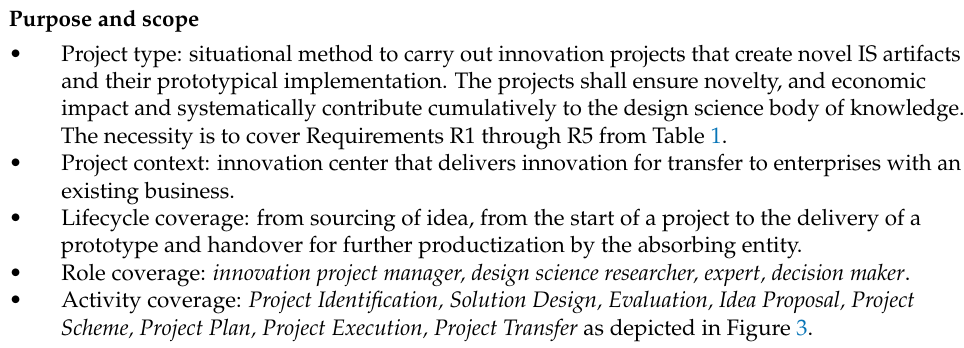
Table 5. Contribution to Method Design